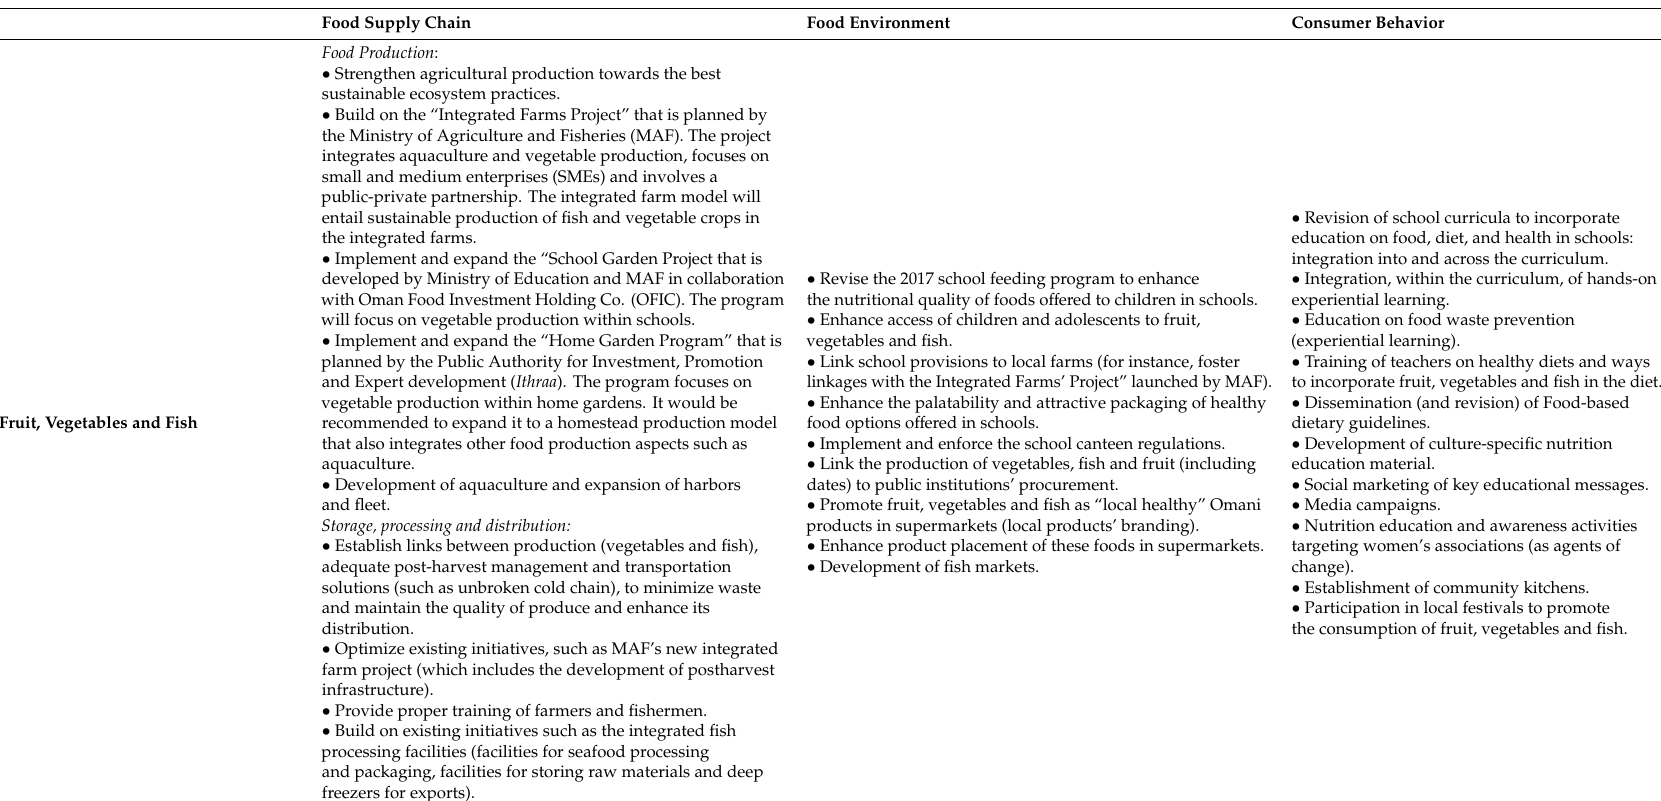
Table 1. Identification of specific entry points within the food system: a roadmap for the Sultanate of